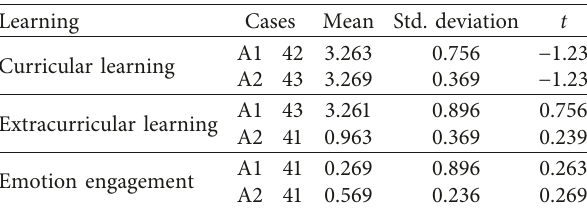
Table 5: Results of descriptive